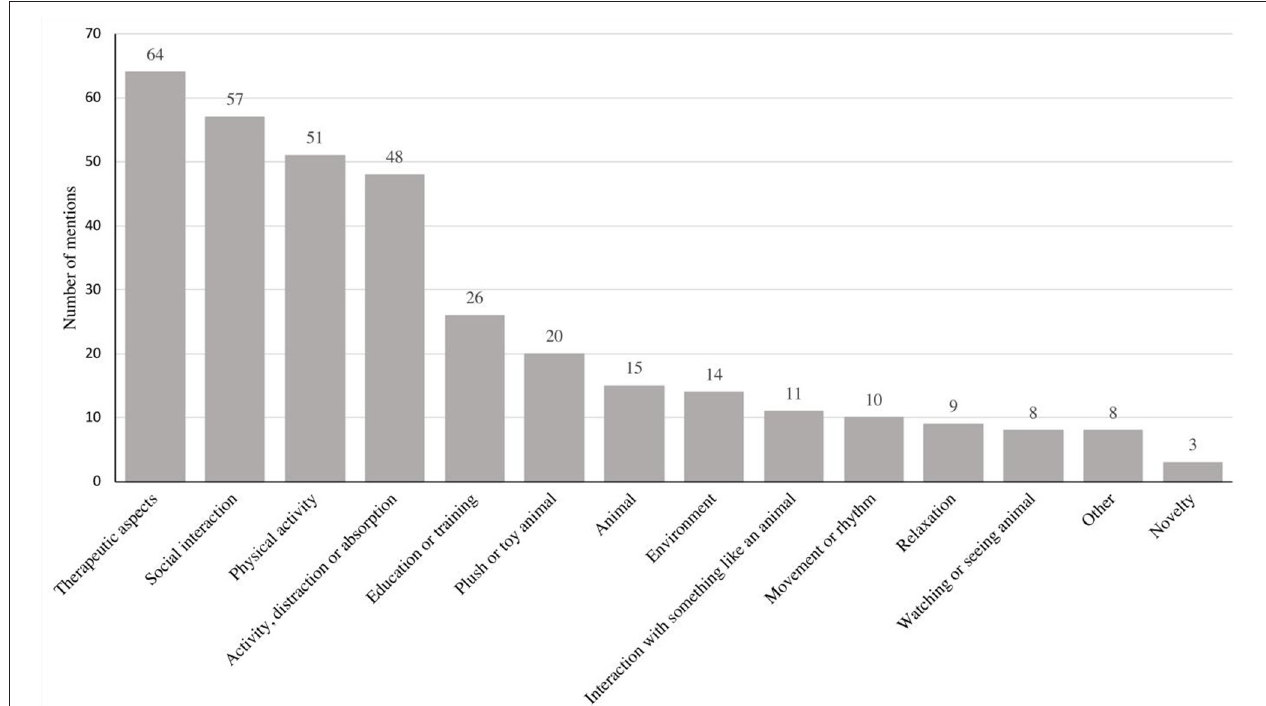
FIGURE 4 | Number of identified non-specific